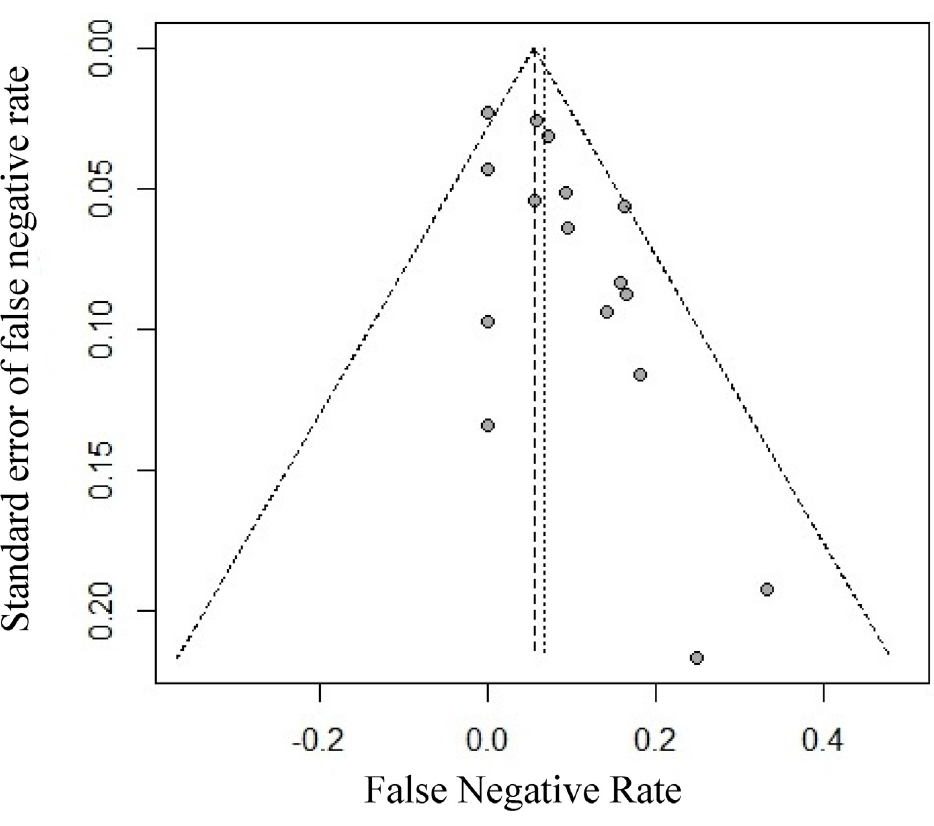
Fig 5. Funnel plot to assess publication bias effect on the FNR. Each dot represents a separate study. The funnel plot revealed no apparent evidence of publication bias.